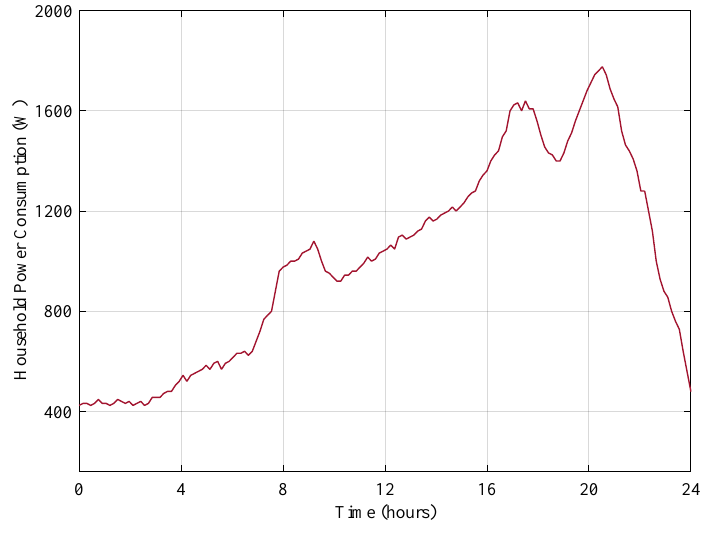
Figure 7. Mean load curve per